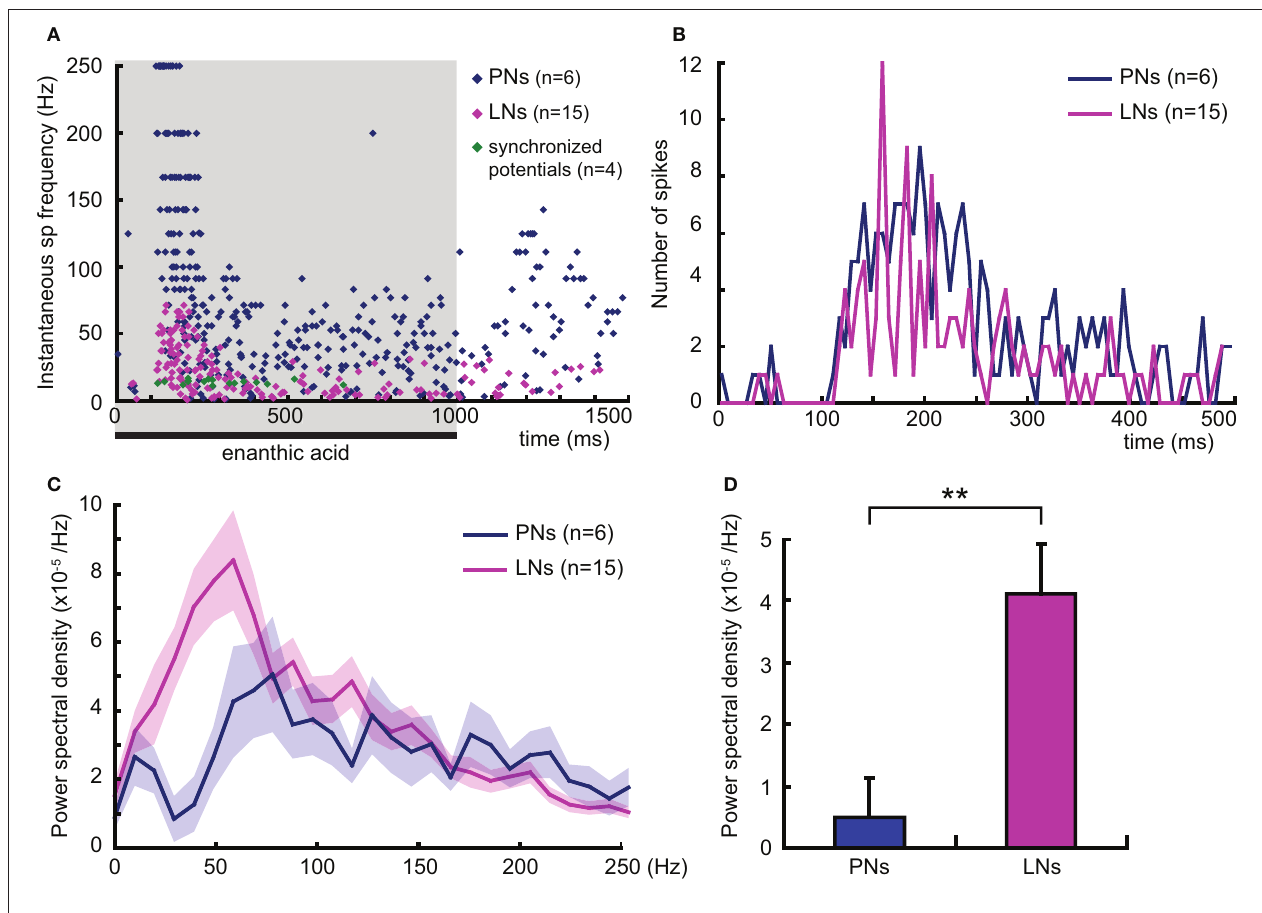
FIGURE 8 | Temporal dynamics of enanthic acid-induced action potentials of secondary olfactory inter neurons. (A) The temporal distributions of enanthic acid-induced action potentials of projection neurons (PNs: blue dots), local interneurons (LNs: magenta dots), and synchronized potentials (green dots). Instantaneous spike frequencies calculated from six projection neurons (16 responses), 15 local interneurons (32 responses), and four VSD imaging (4 responses) were summarized. The time distributions of instantaneous spike frequencies in individual secondary olfactory neurons are available as Figure A1 . The shaded area indicates the period of stimulation with enanthic acid in intracellular recording. (B) Time histograms of enanthic acid-induced action potentials of projection neurons (PNs: blue line) and local interneurons (LNs: magenta line). 202 spikes obtained from 6 projection neurons and of 131 spikes